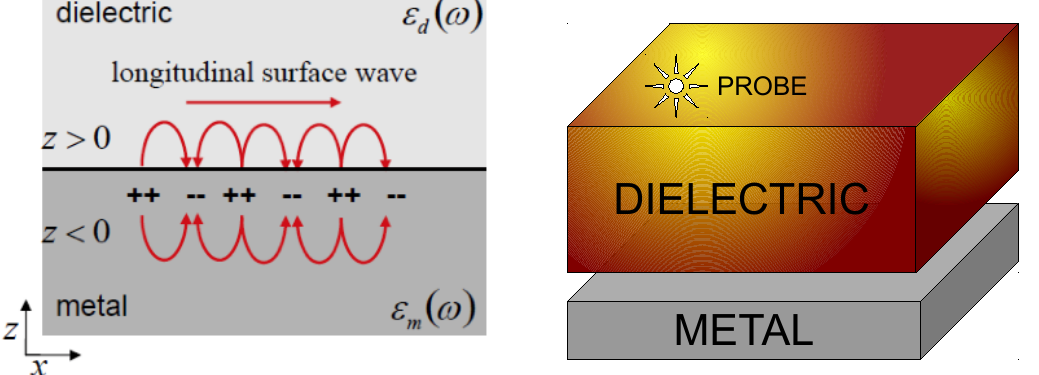
Figure 1. Implemented geometry in COMSOL ( left ), and geometry that models Surface Plasmon Polaritons (SPP) propagation from a metal-dielectric interface ( right